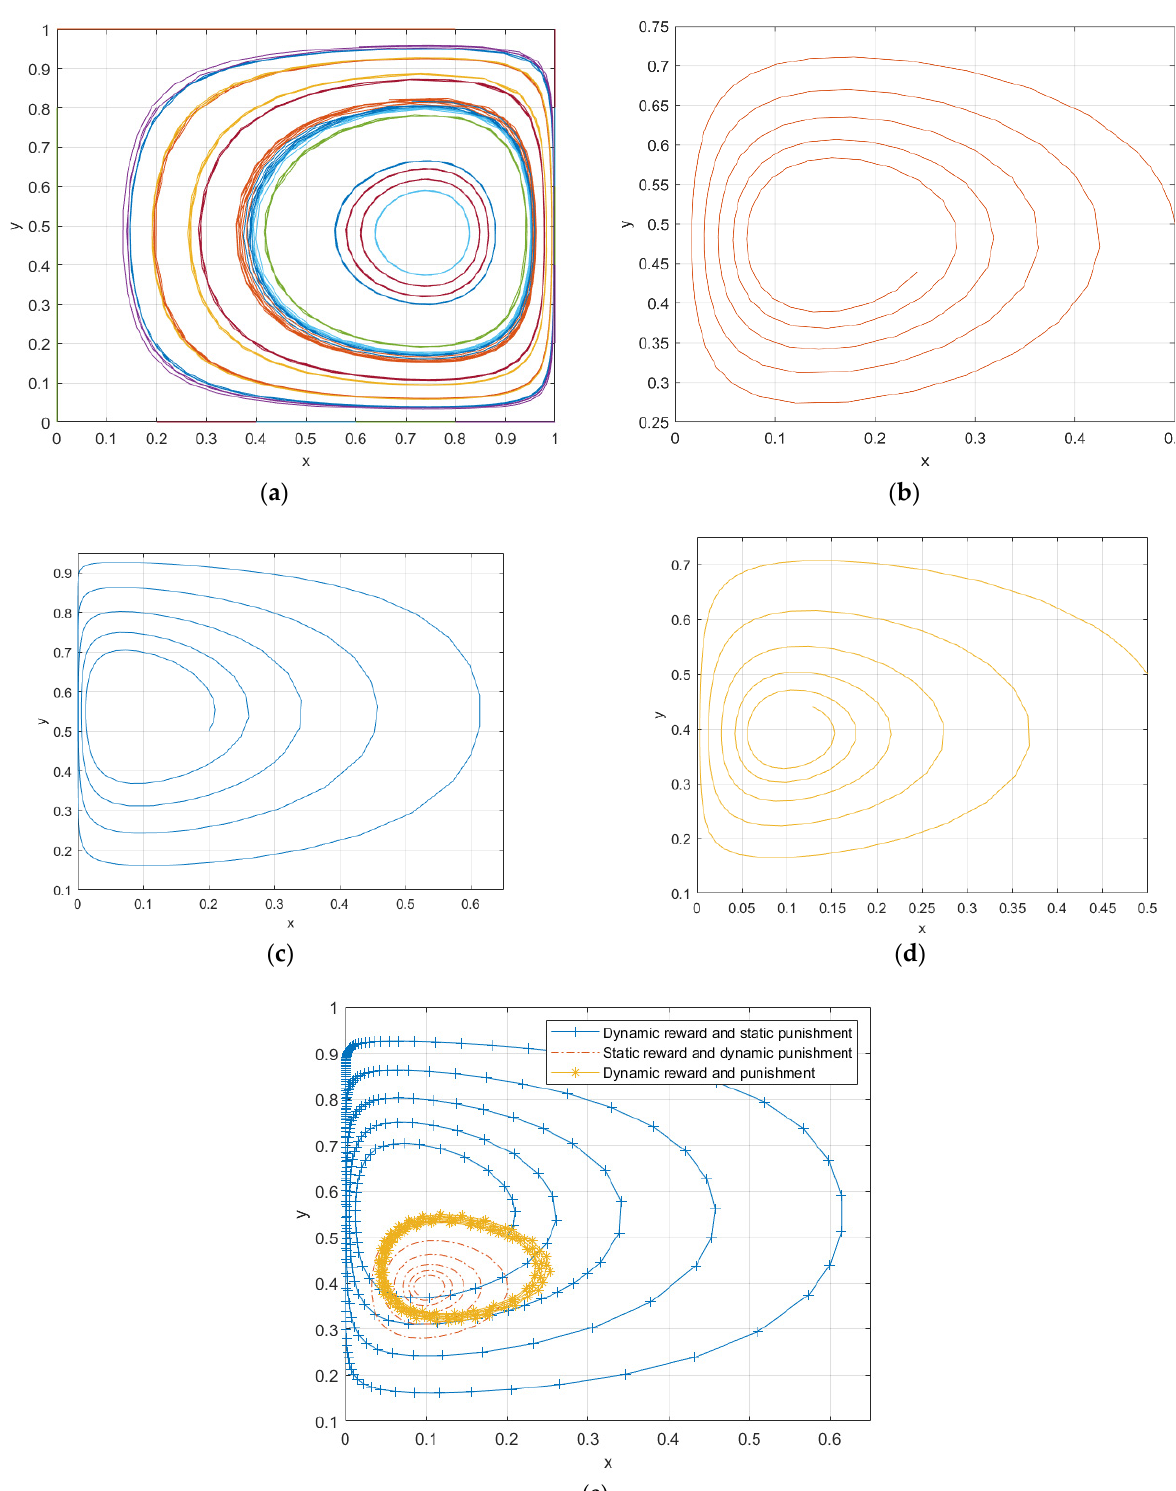
Figure 3. ( a ) Evolutionary path diagram under static reward and punishment (When the time t is from 0 to 100, the evolution trajectory of the evolutionary game). ( b ) Evolutionary path diagram under dynamic reward and punishment. ( c ) Evolutionary path diagram under dynamic reward and static punishment. ( d ) Evolutionary path diagram under static reward and dynamic punishment. ( e ) Evolutionary path diagram under three policies.